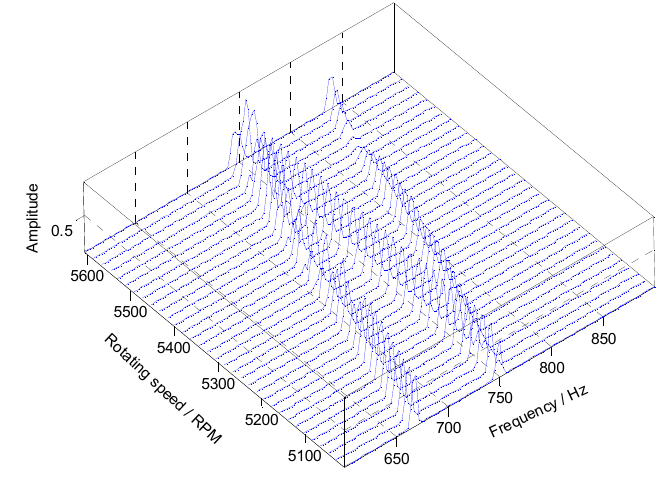
Figure 9. Time-varying order spectrum of the angular-domain reconstruction signal.